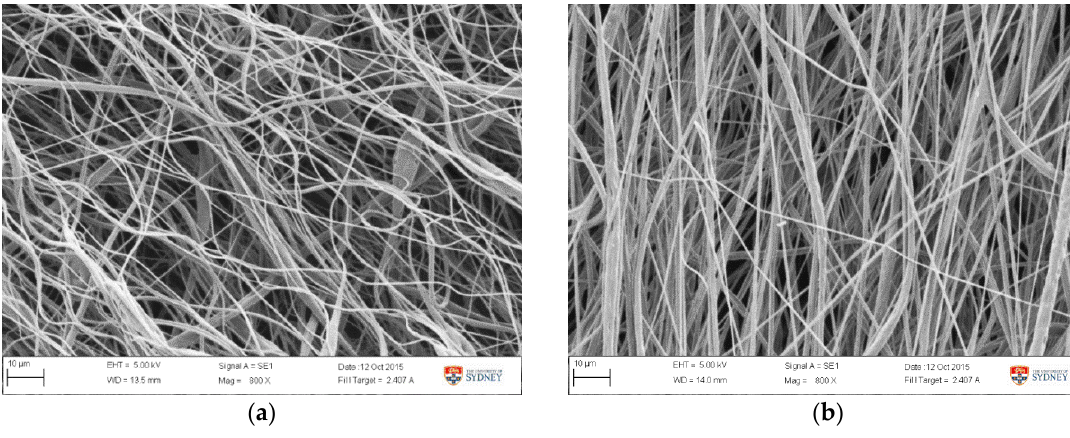
Figure 8. SEM image of fibre morphology obtained from the optimized setting from ( a ) day 1, run 2 and ( b ) day 2, run 6.